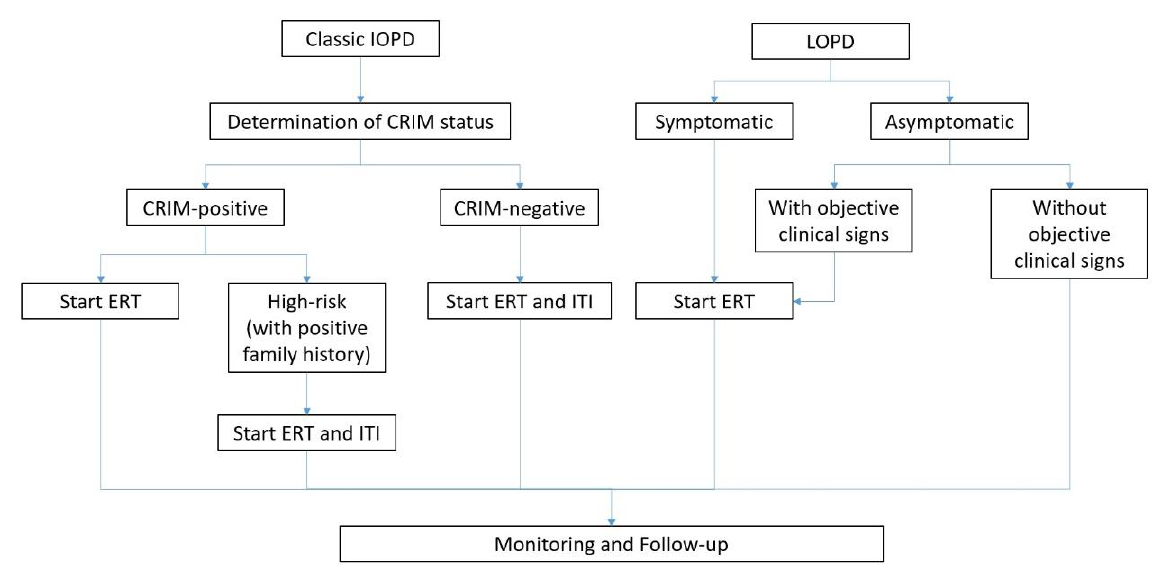
Figure 1. ERT treatment flowchart of PD.